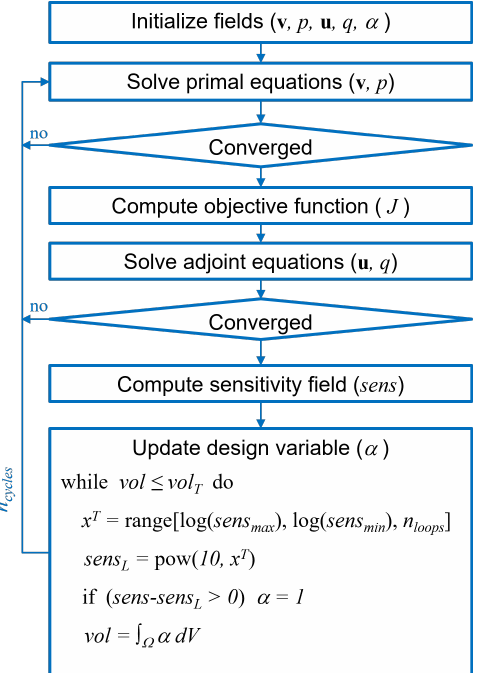
Figure 5. Flowchart of the topology optimization cycles using continuous adjoint method, with ex- plicit design variable